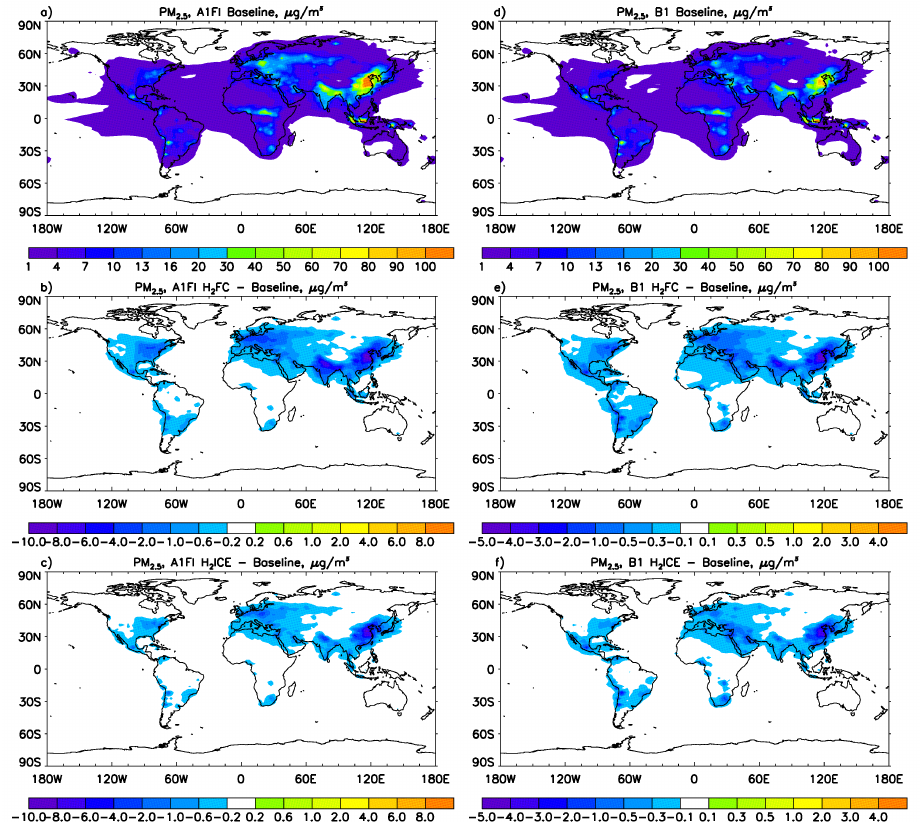
Figure 12. CAM-Chem simulated 2050 annual mean surface PM 2.5 concentrations in the A1FI 2 Fig. 12. CAM-Chem simulated 2050 annual mean surface PM 2 . 5 concentrations in the A1FI (a) and B1 (d) baseline scenarios and (a) and B1 (d) Baseline scenarios and differences for the H 2 Fuel Cell (H 2 -FC) and H 2 Internal 3 Combustion Engine (H 2 -ICE) scenarios (b, c, e and f). Note the different scales. 4